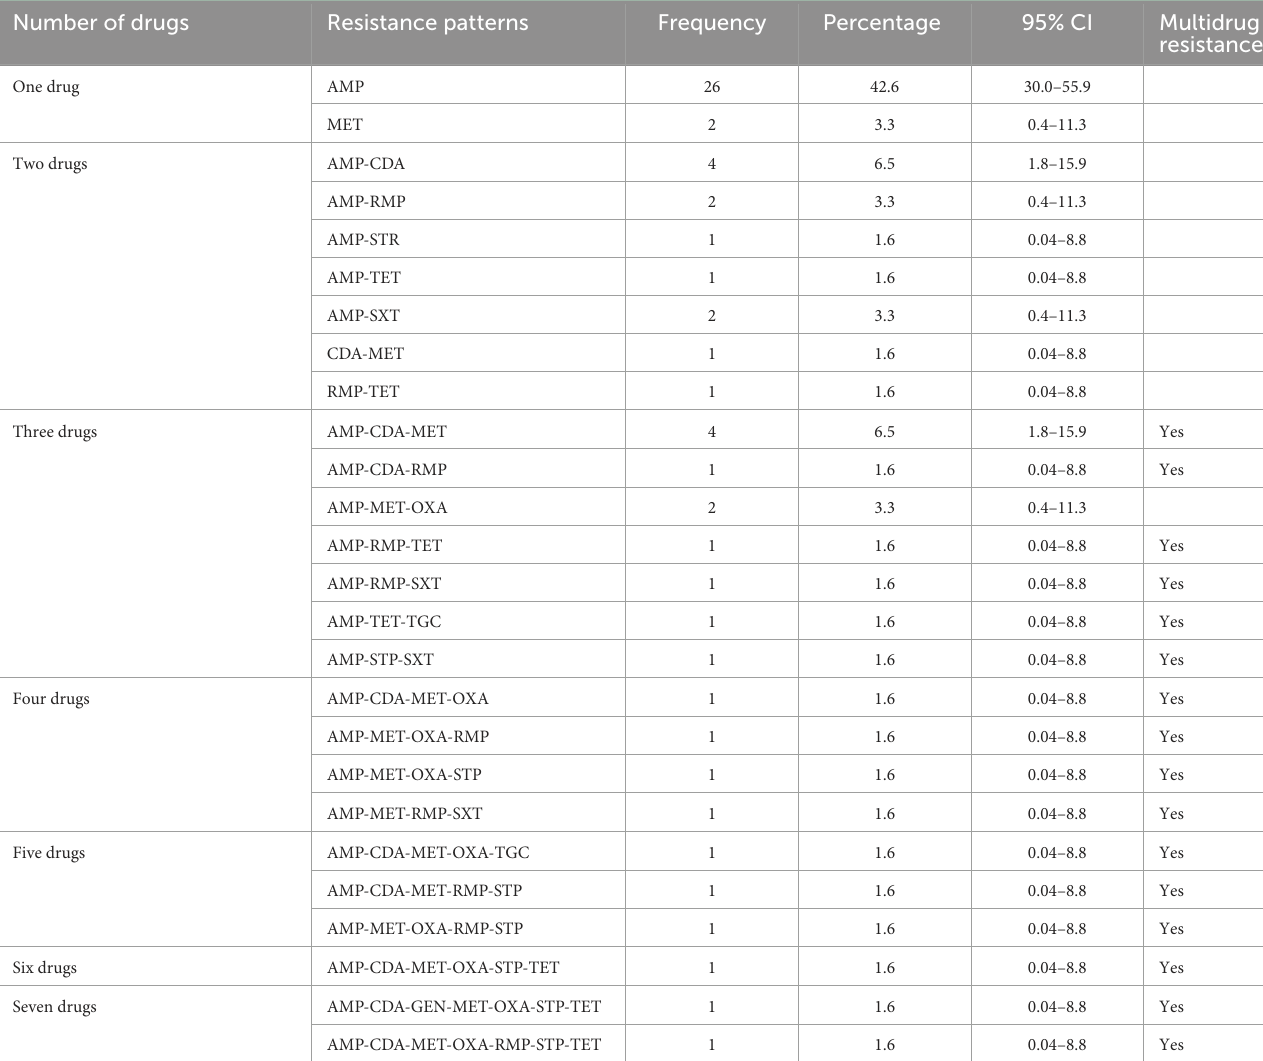
TABLE 5 Multidrug resistance pattern of Staphylococcus